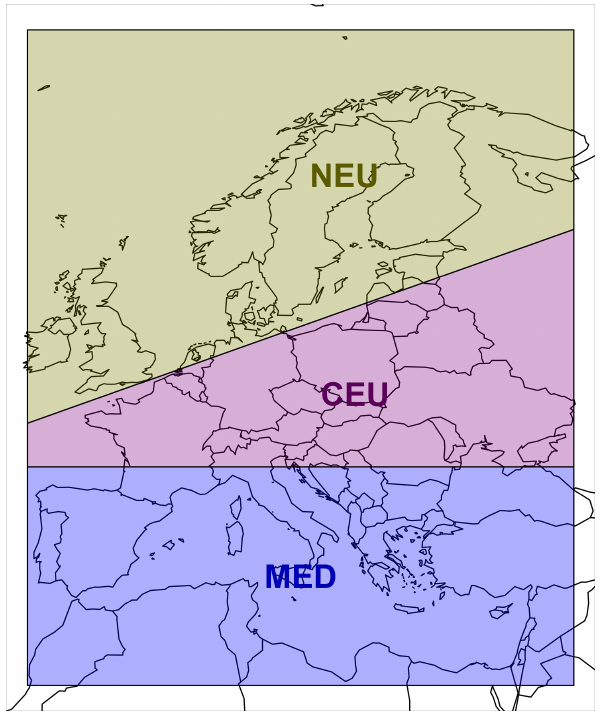
Figure 2. Regions considered in the analyses. The three colored regions are taken from the IPCC SREX report (Seneviratne et al.,